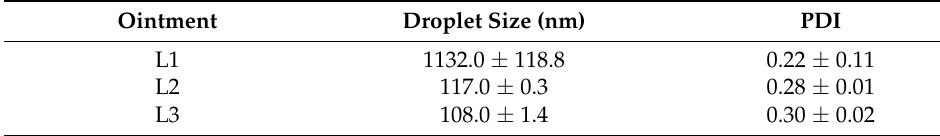
Table 2. Droplet size of lidocaine ointment after dilution.